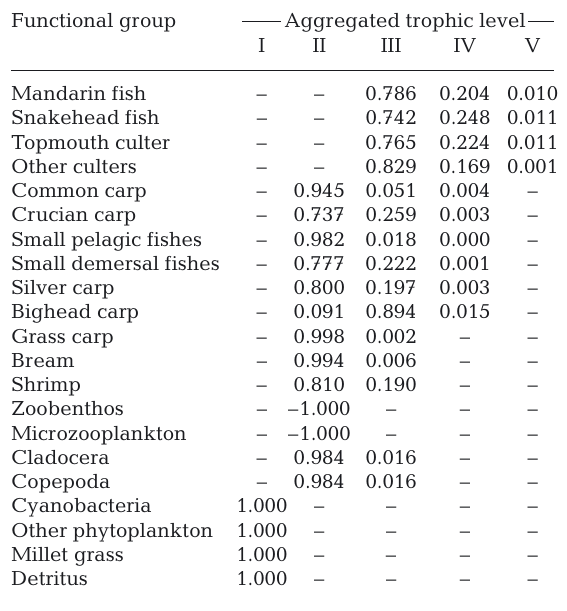
Table 4. Aggregated trophic level decomposition of the functional groups in the Lake Shangshe ecosystem. –: no Functional group